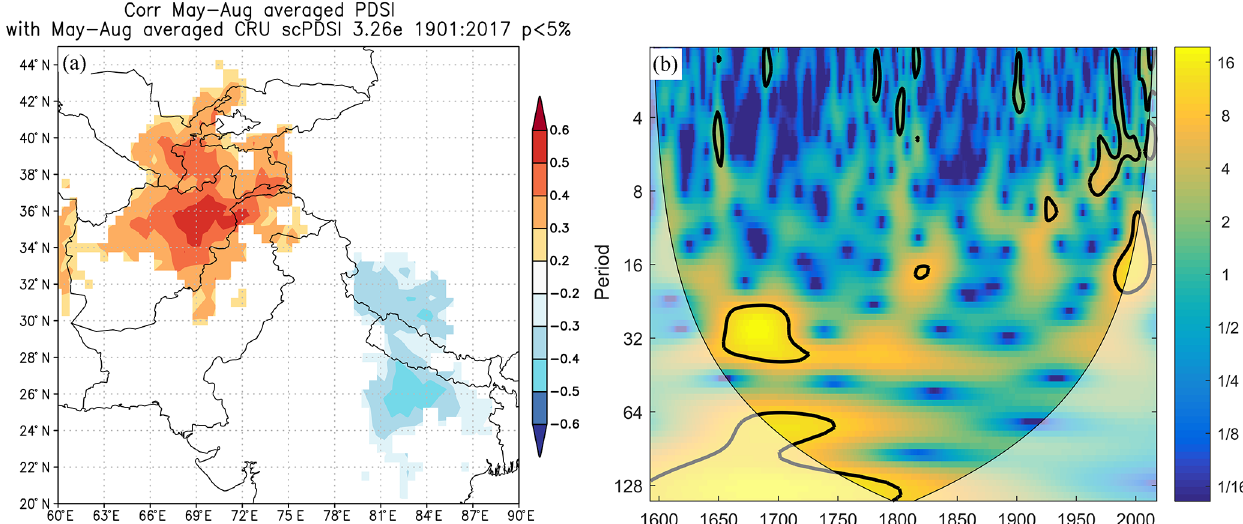
Figure 8. (a) Spatial correlation between the actual May–August PDSI and the reconstructed May–August scPDSI (1901–2017). (b) The wavelet analysis of the reconstructed scPDSI in the Chitral Hindu Kush ranges, Pakistan. The 95% significance level against red noise is shown as a black contour.